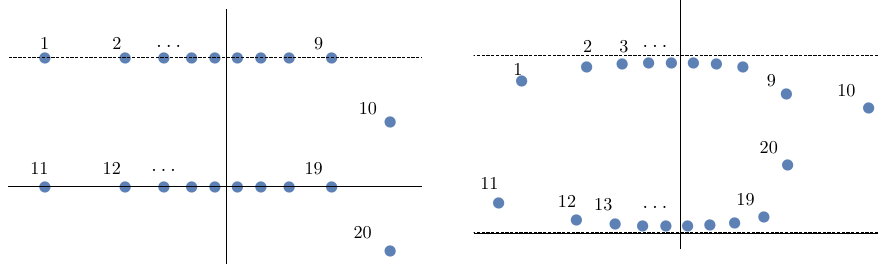
= (cid:14)I M = 1. (cid:0) 1 2 2 = (cid:14)I M = 1 ( CPT - and D -transformed state). +1 2 2 , S z = 0 and k = 1 . 5 30